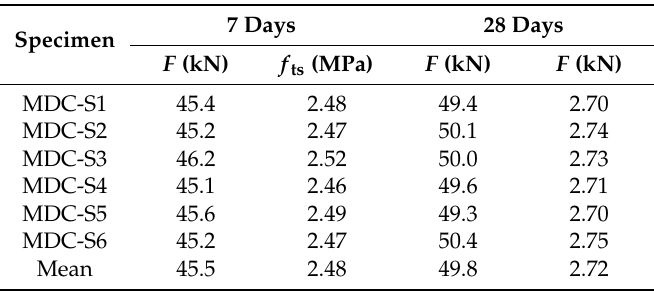
Table 5. Splitting test results of test specimen series MDC-S (magnetically driven concrete-steel slag with shaking table vibration).